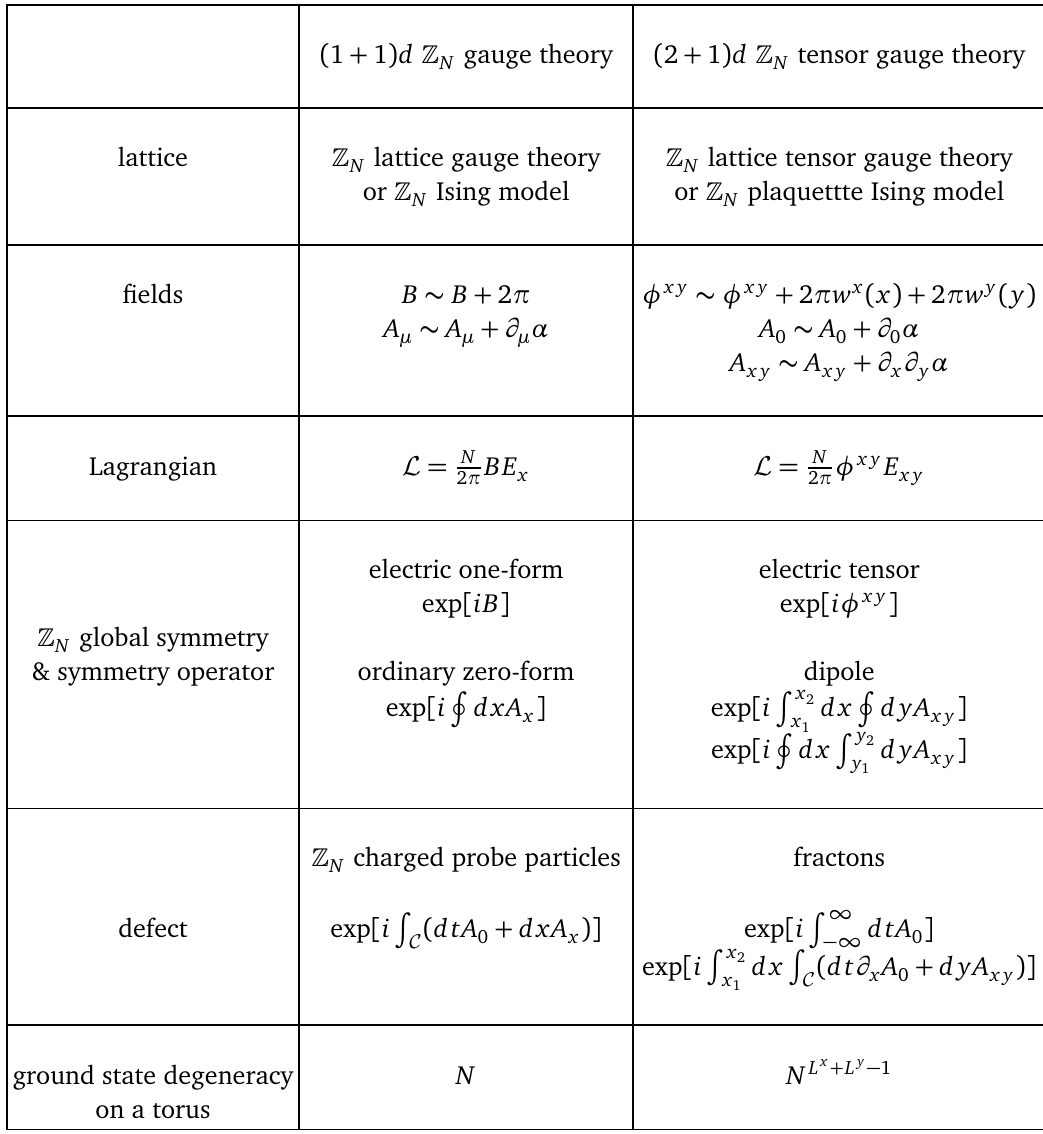
Table 4: Comparison between the ordinary 1 + 1-dimensional (cid:90) the 2 + 1-dimensional (cid:90) tensor gauge theory. Detailed explanations will be given N in the body of the